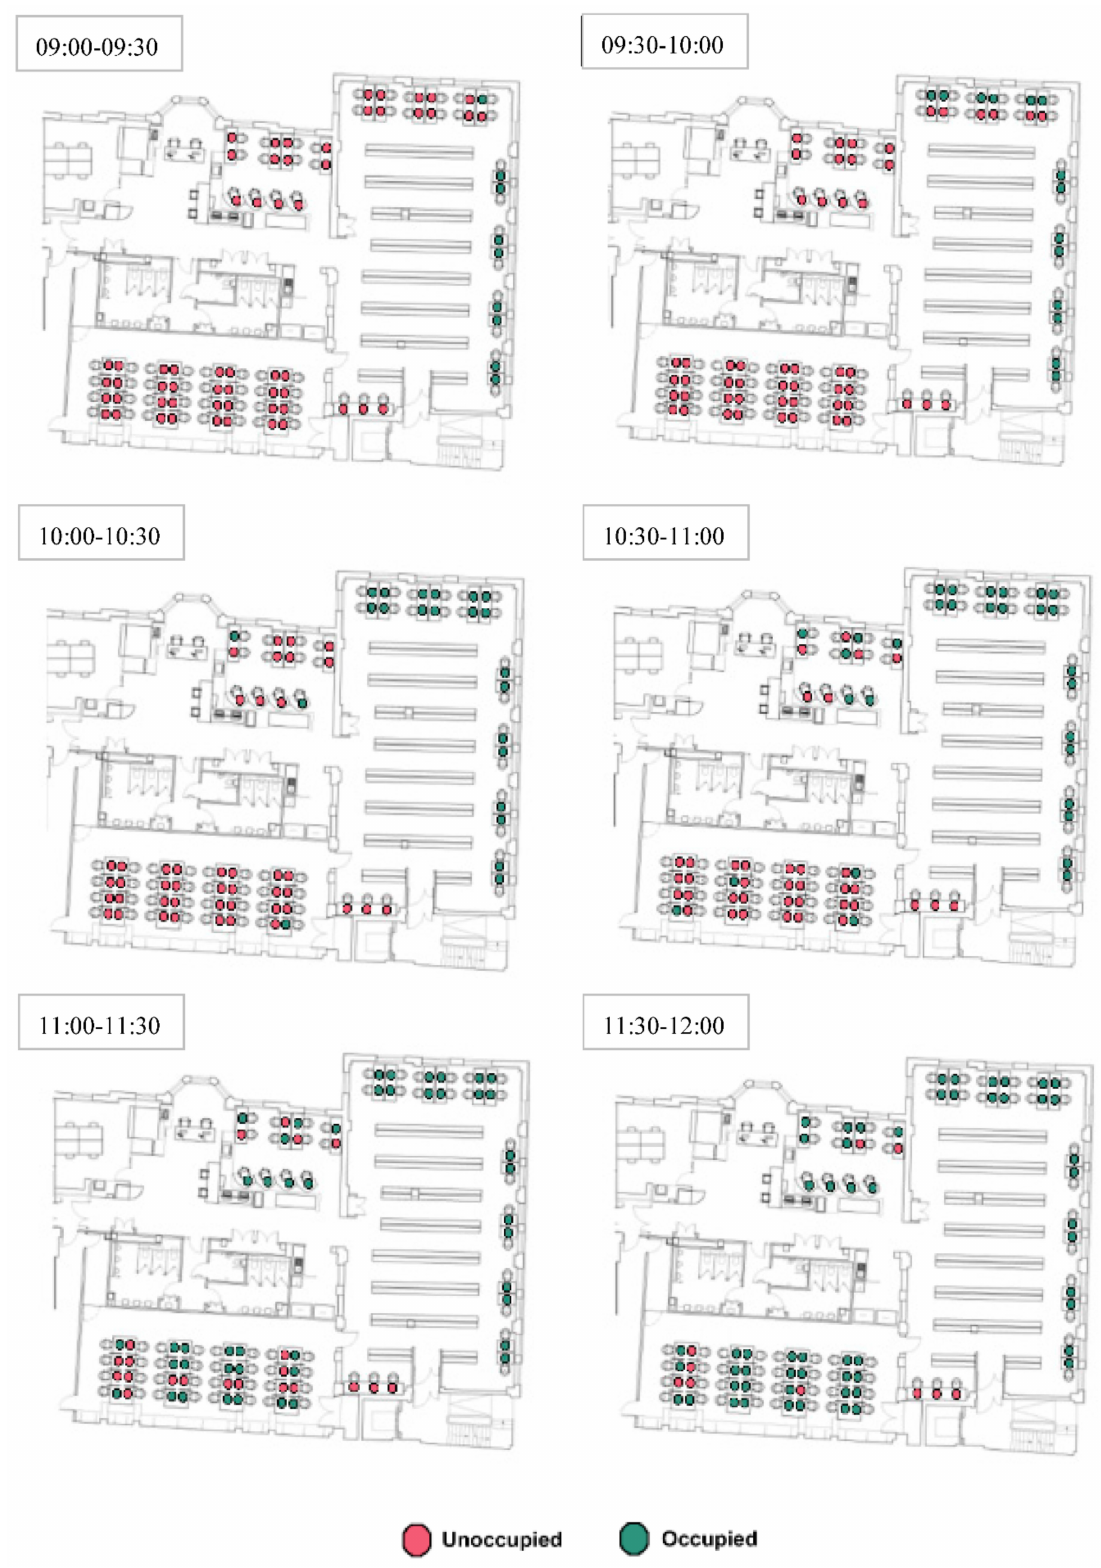
Figure 6. Seating preferences of the students in the early hours before